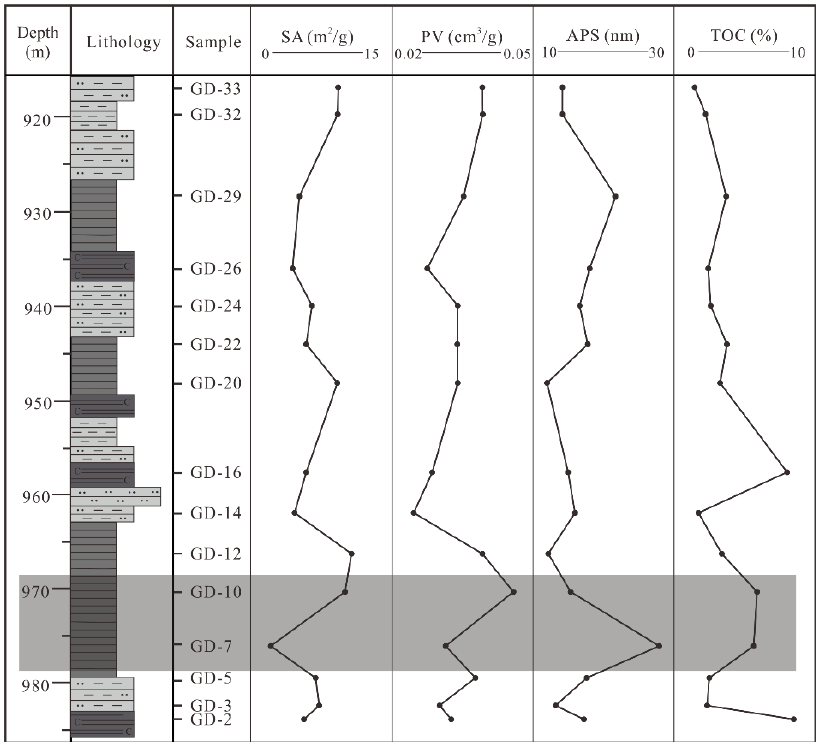
Figure 11. Relationships between pore volume and surface area ( a ), surface area and average pore size ( b ), pore volume and average pore size ( c ), surface area and fractal dimension ( d ).